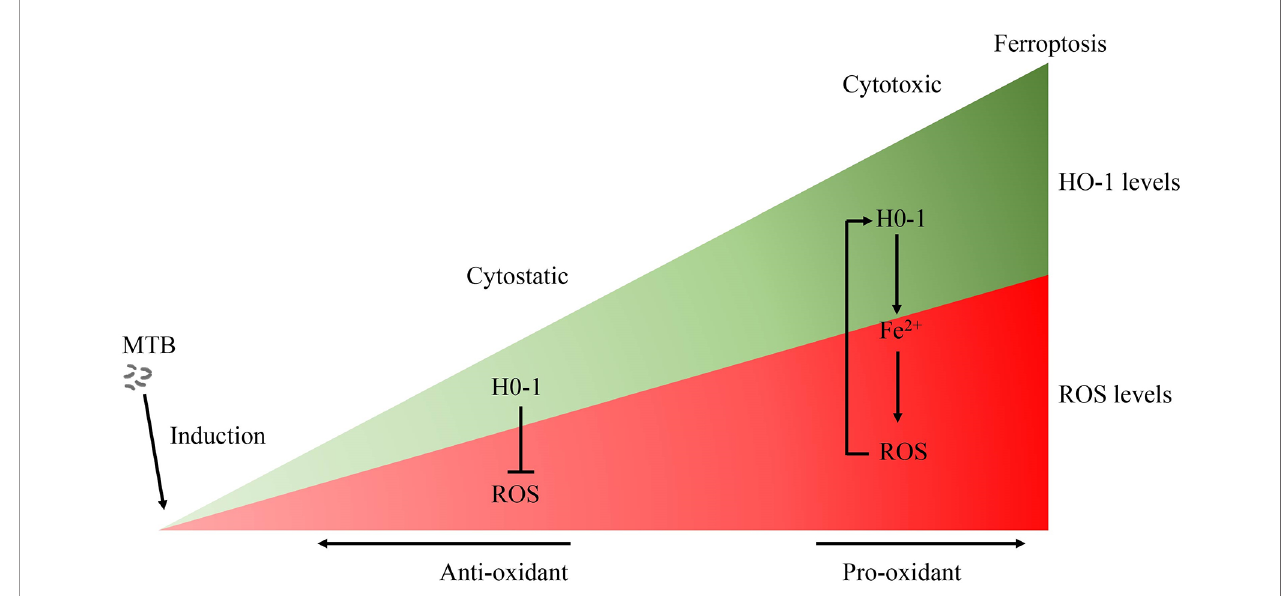
FIGURE 3 | The role of HO-1 in MTB infection. Free heme is highly cytotoxic via the production of free radicals. Accordingly, when HO-1 is activated moderately, HO-1 exerts a cytoprotective effect by neutralizing ROS. Conversely, the large amounts of excessive free heme released during the late stages of tuberculosis overwhelms the cytoprotective effects of HO-1, thereby contributing to oxidative stress and excessive ROS production. The over-activation of HO-1 becomes detrimental due to the excessive labile Fe 2+ , along with ROS overload, leading to oxidative-cell death (ferroptosis), which contributes to the spread of infection. MTB, Mycobacterium tuberculosis; HO-1, heme oxygenase-1; ROS, reactive oxygen species; Fe, free